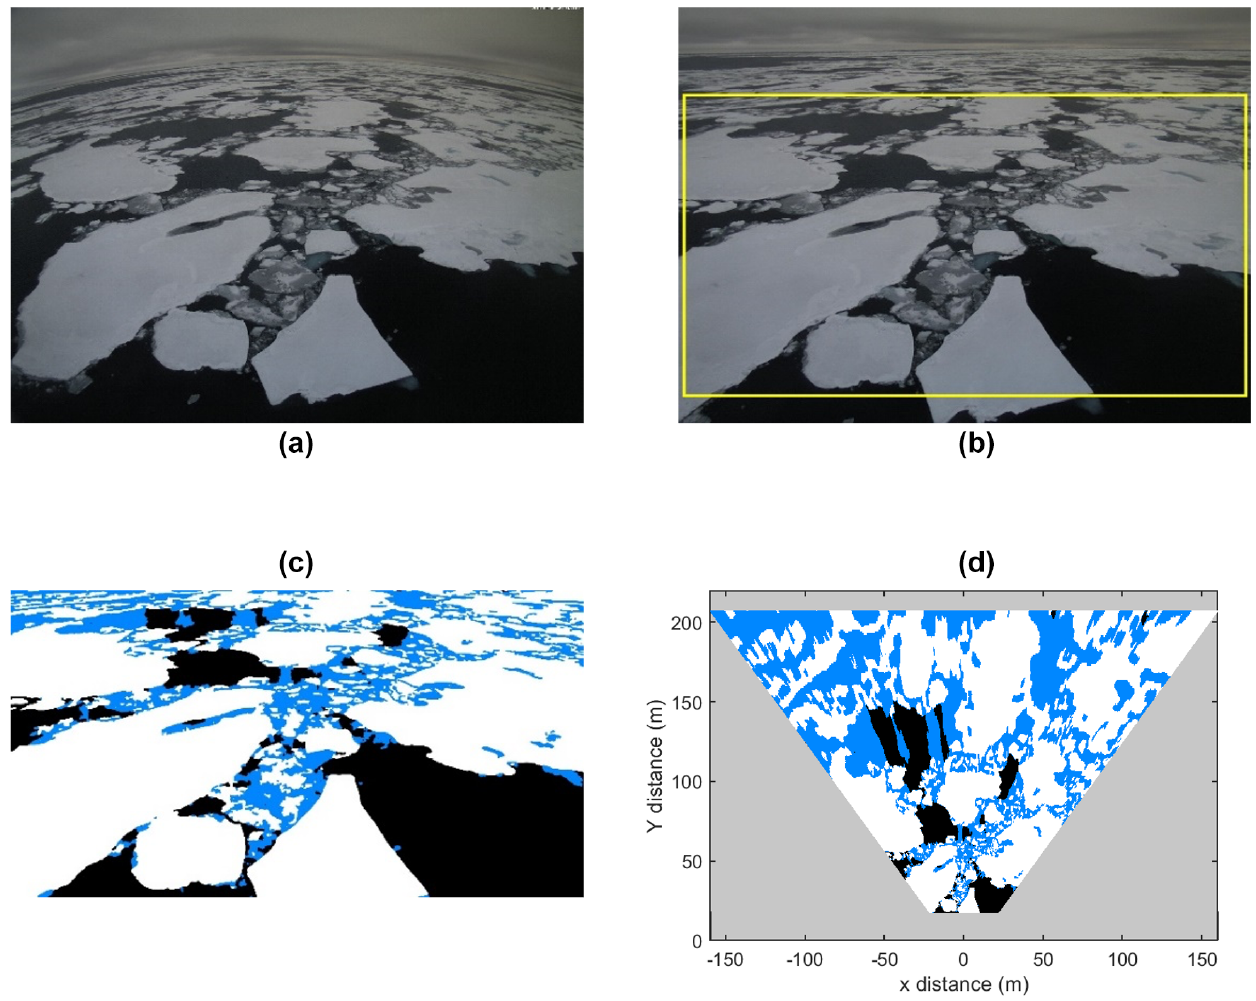
Figure A1. An example of the image processing workflow. Panel (a) is an example raw image; (b) shows the image corrected for the lens distortion, where the region of focus is shown by the yellow rectangle; (c) shows the image after processing by the OSSP algorithm where the masking colours – white, blue and black – represent ice, melt pond or submerged ice and open water areas respectively; (d) shows the orthorectified image showing the true distance of each surface feature away from the